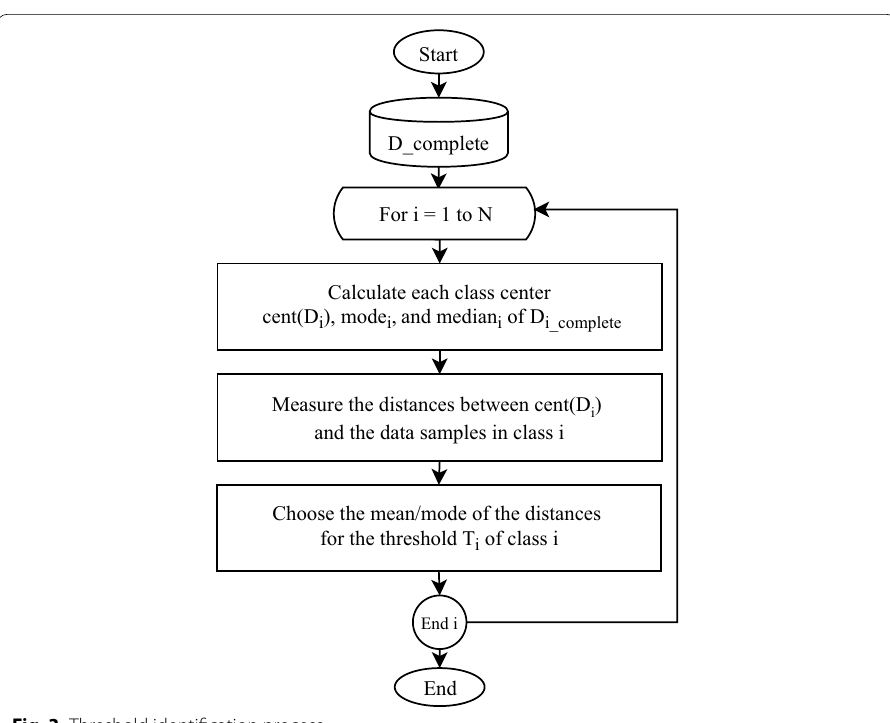
Fig. 3 Threshold identification process